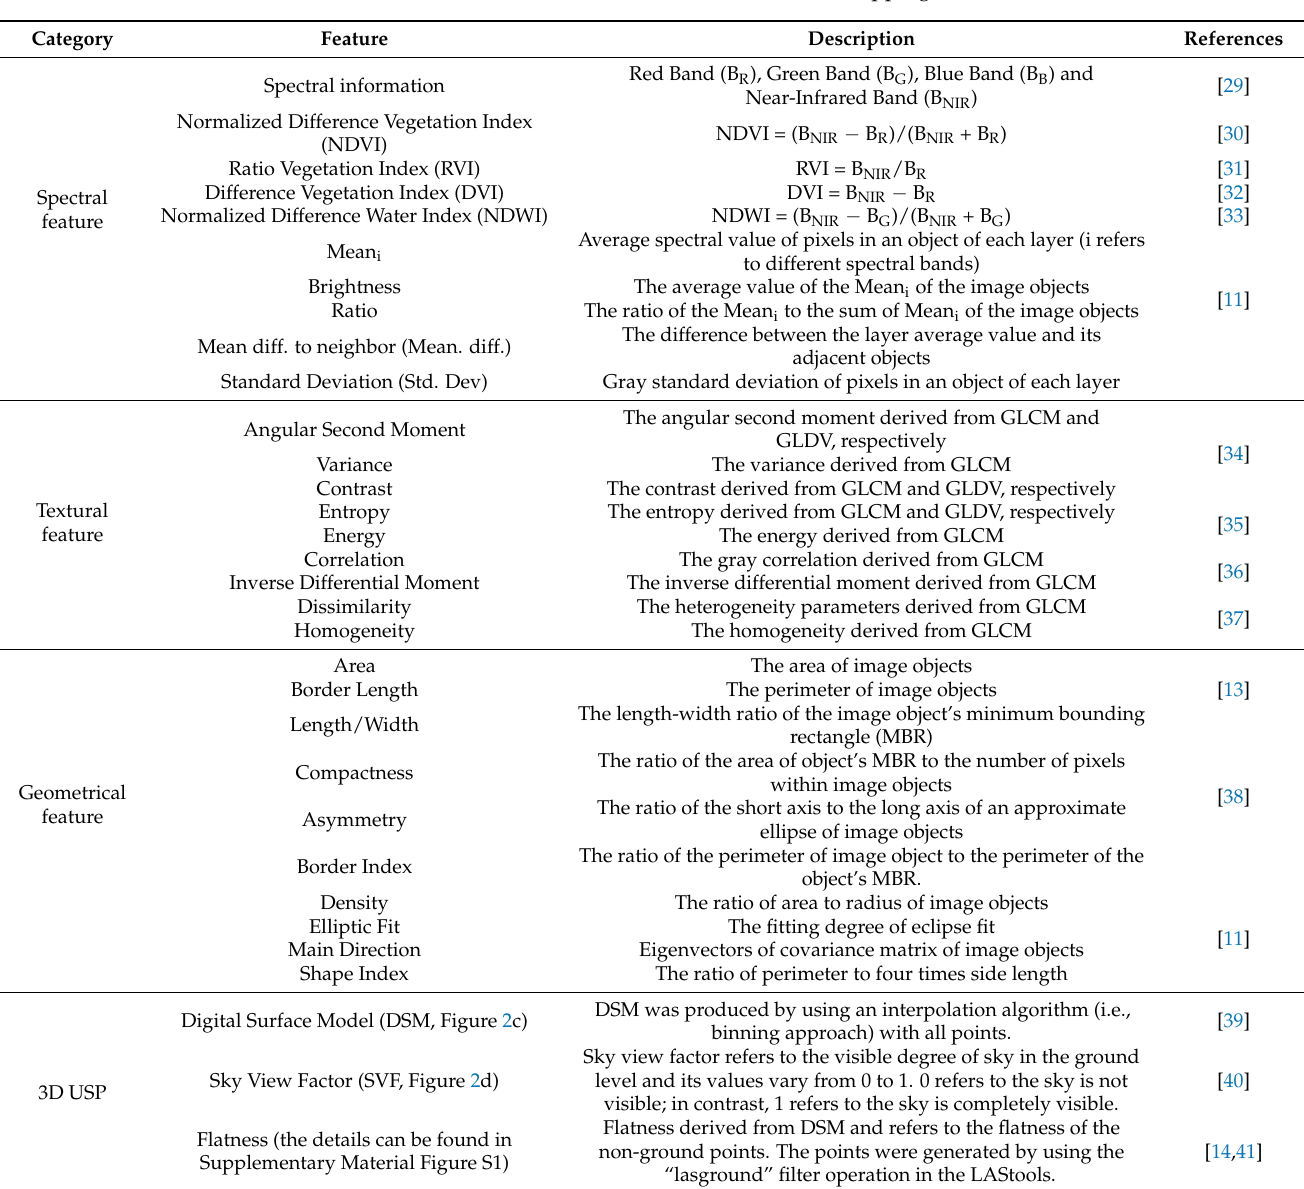
Table 1. Multi-feature extraction for land cover mapping.